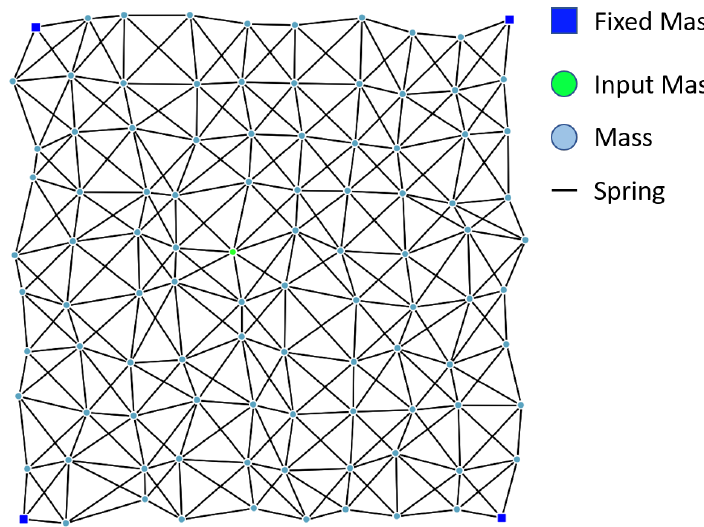
Figure 2. Visualisation of a mass-spring system as used in our experiment. The dark blue squares on the corners represent fixed masses (to fixate the network in space); the green circle in the middle is the input mass (where force is applied as input), the light blue circles are masses, and the black lines represent the nonlinear springs, connecting masses with each other.